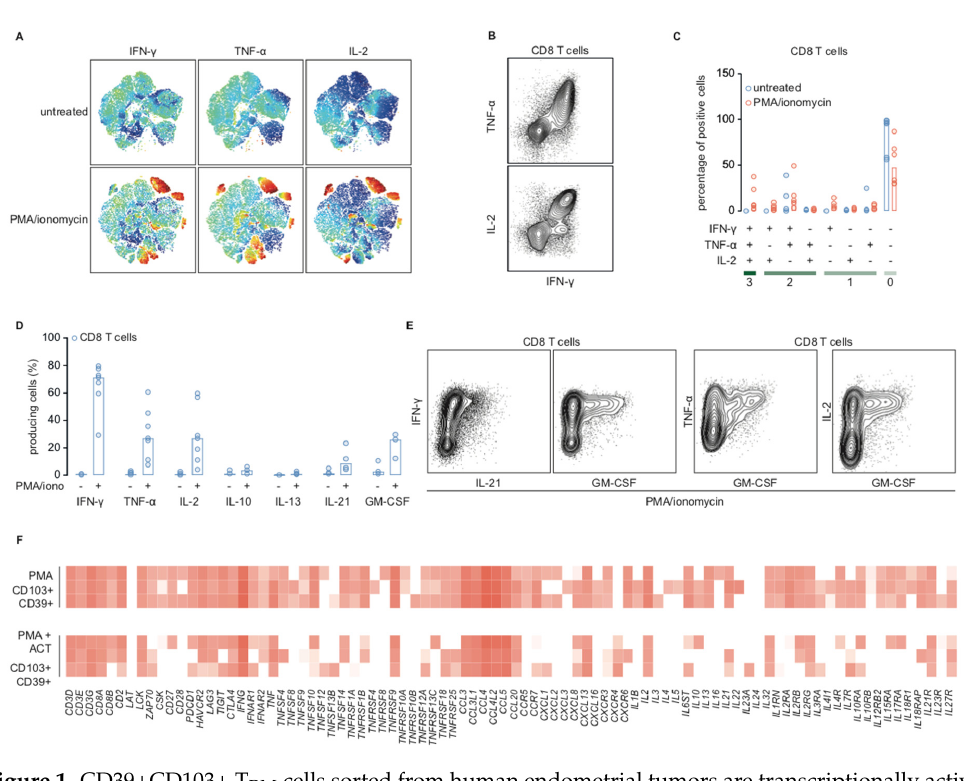
Figure 1. CD39 + CD103 + T RM cells sorted from human endometrial tumors are transcriptionally active. Figure 5. Activated CD8+ T cells are polyfunctional T cells that are responsive to (re)activation. ( A ) t- ( A ) Overview of experimental set-up. CD39 + CD103 + T RM cells and CD8 + TIL were sorted from stochastic neighbor embedding plots of flow cytometry data of three endometrial tumor digests